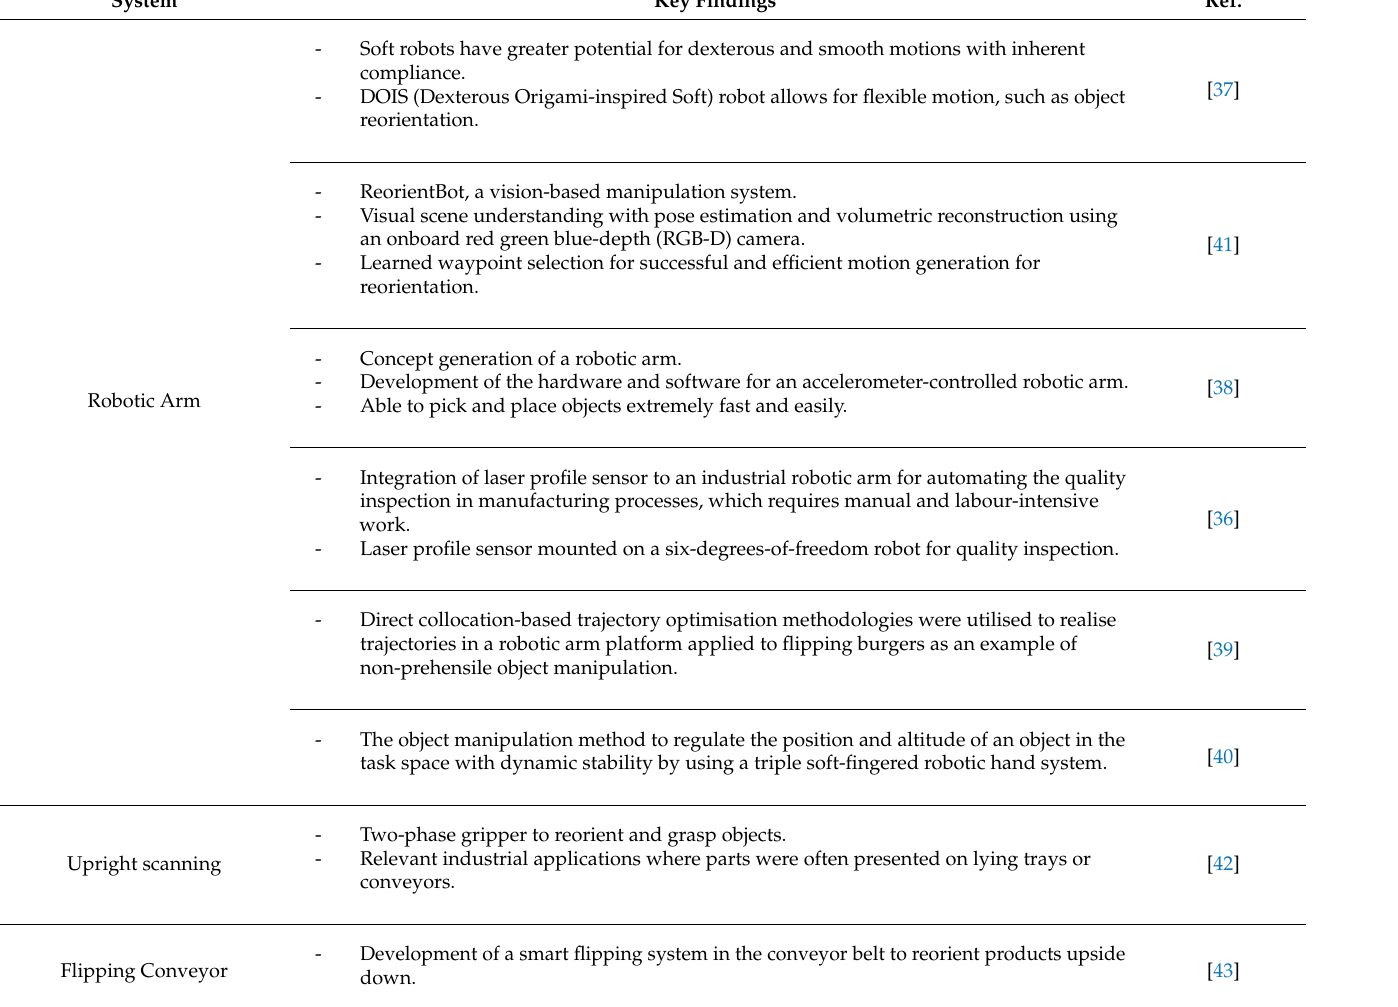
Table 4. Summary of key findings of past studies on flipping systems. Key Findings